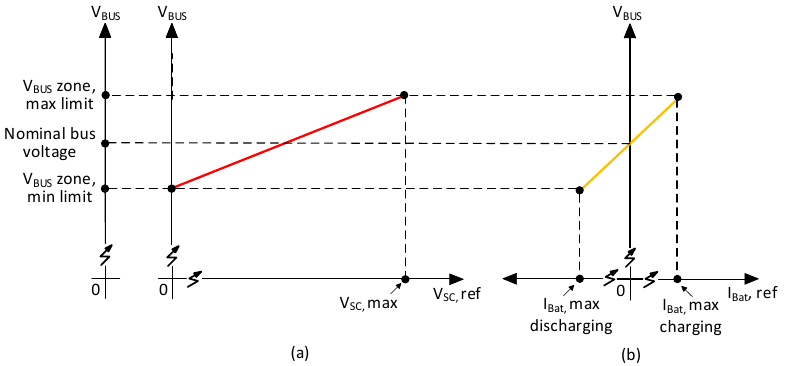
Figure 8. The classical droop control for the SCES/battery HESS: ( a ) The droop curve with low slope for the SCES; ( b ) the droop curve with high slope for the ba tt ery.